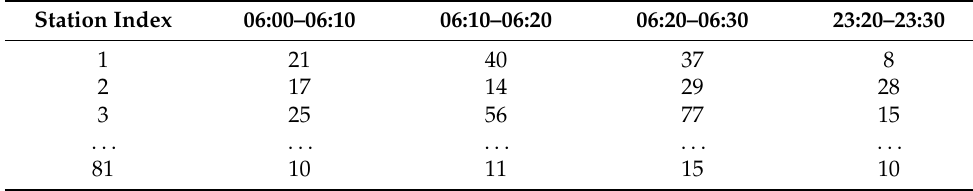
Table 2. Example of passenger